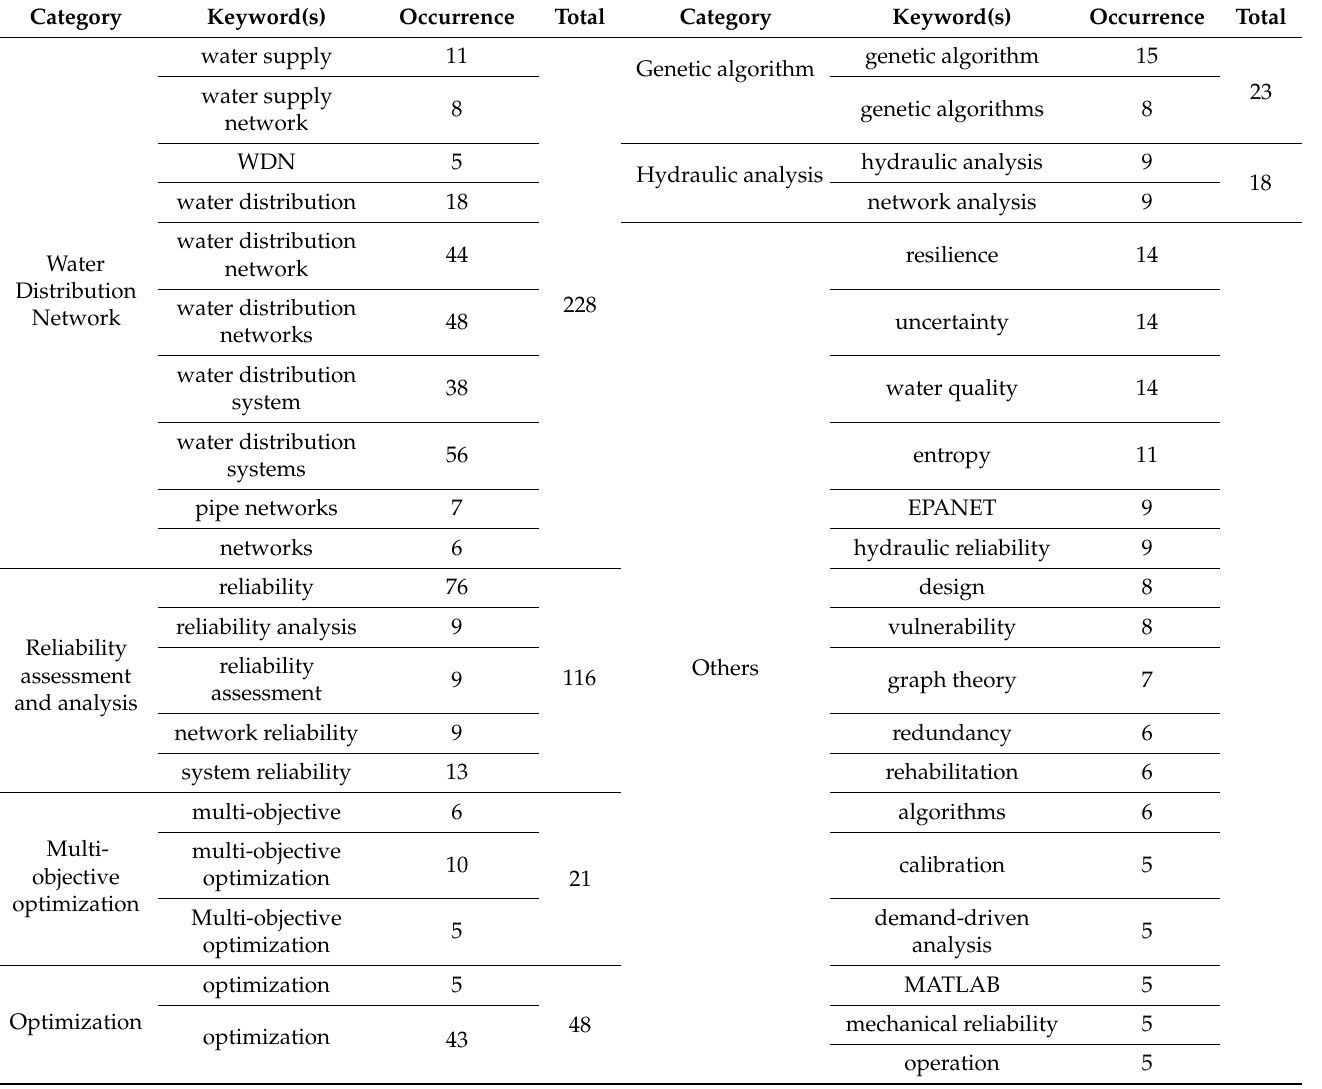
Table 6. Frequently used author